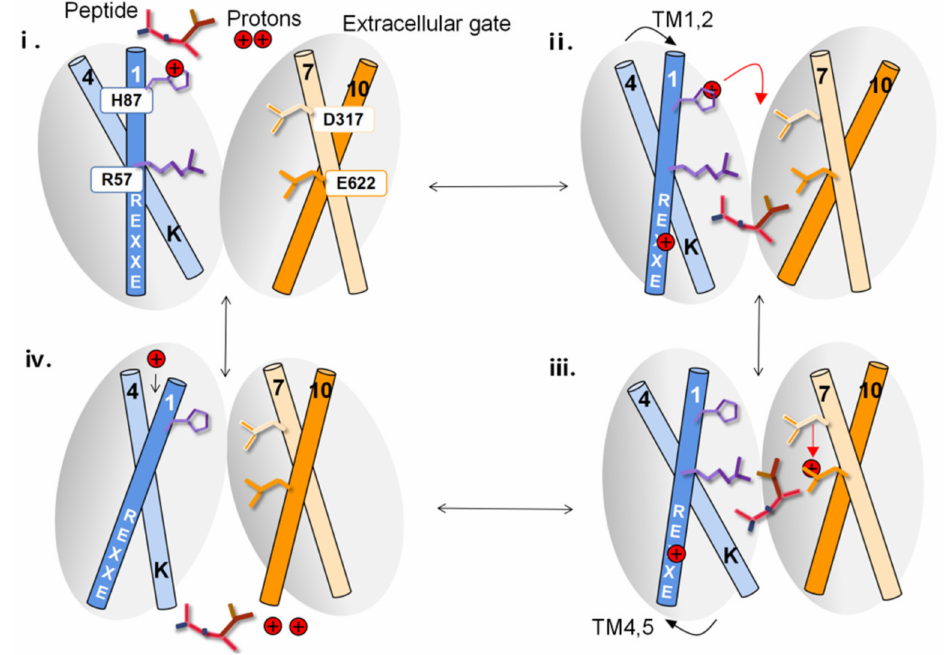
Figure 2. Transport mechanism of PepT2. Schematic representation of the transport cycle for PepT2 has been described in the